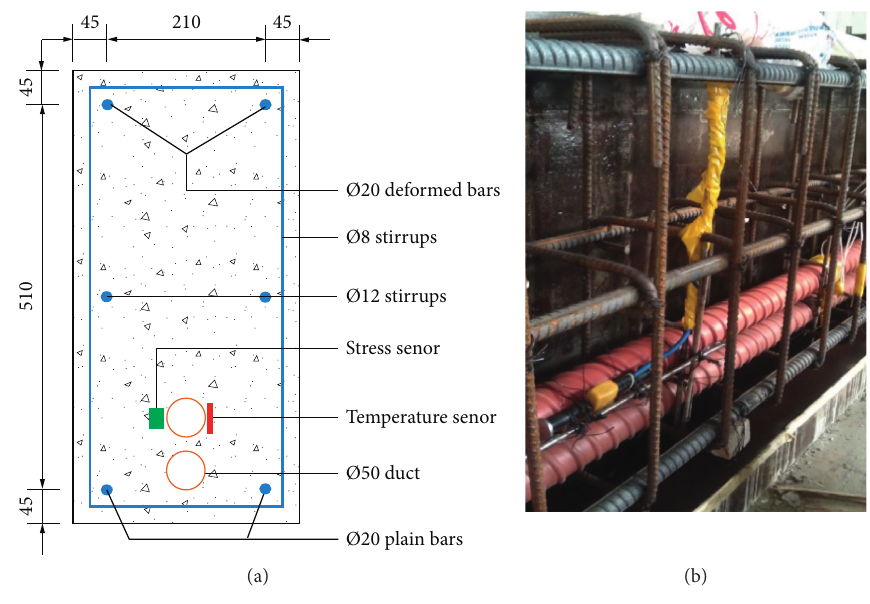
Figure 5: Arrangement of sensors (mm). Table 9: Properties of asphalt mixture with different ratios of BRA.